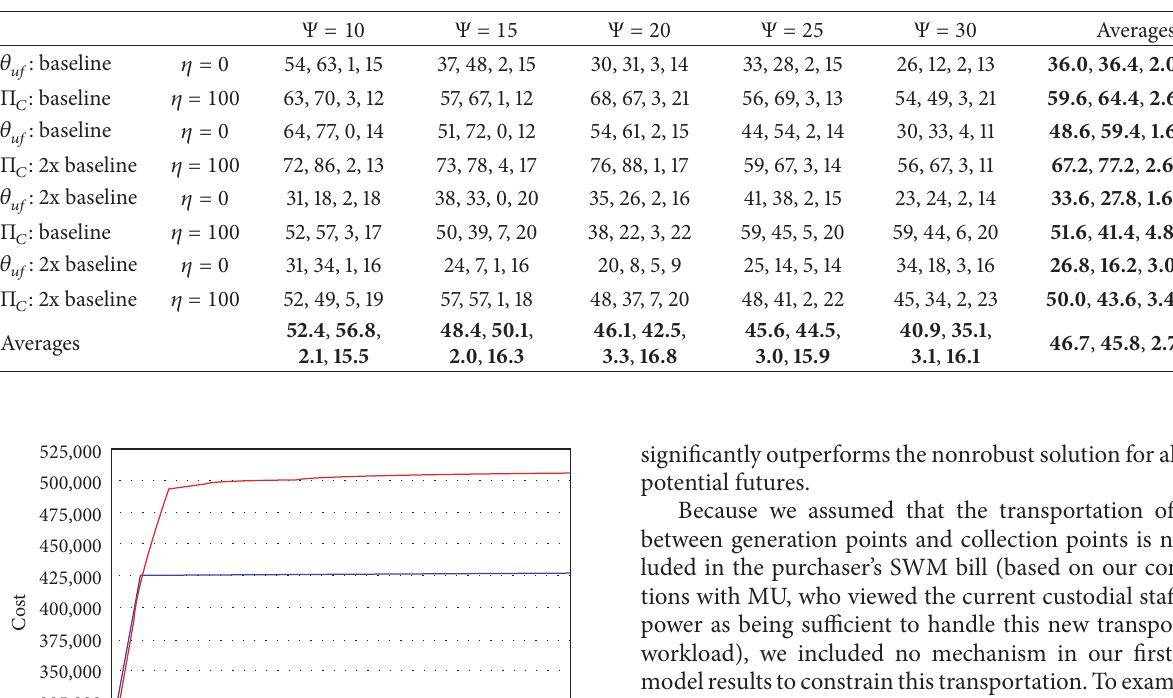
Table 4: Further computational results, maximum transport distance of 0.25 miles.